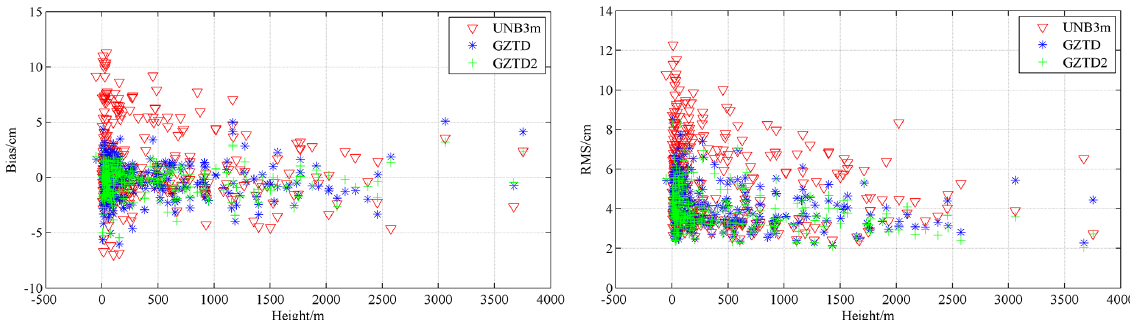
Figure 10. Global distributions of bias and rms for different models with respect to height.